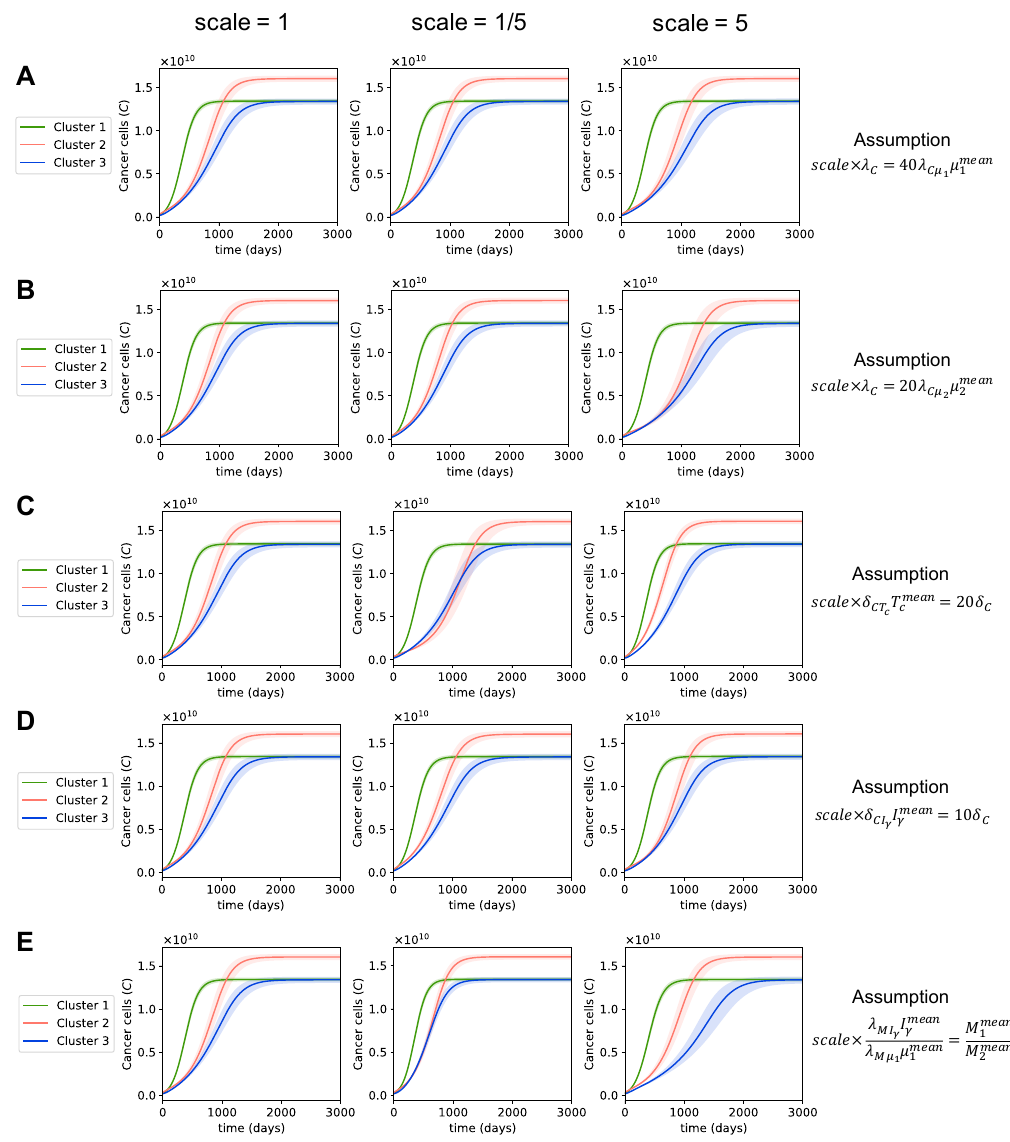
Figure 6. The dynamics of cancer when the assumptions of the sensitive parameters are varied. ( A – E ) The cancer growth of all three clusters for each assumption of sensitive parameters. The left plot in every sub-figure is the original cancer dynamics, the middle and right plots are the cancer dynamics obtained when the given assumption is scaled by 1/5 and by 5,